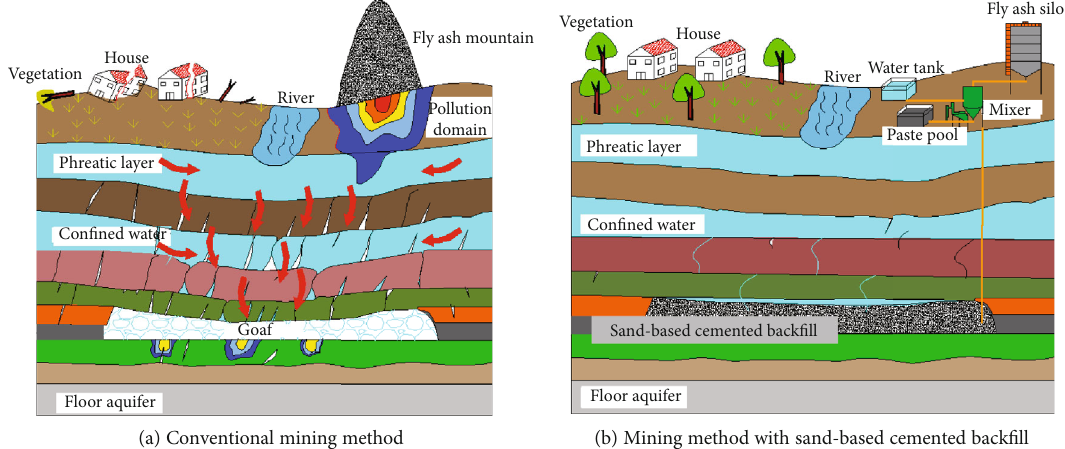
Figure 1: Occurrence state of mine water under di ff erent mining